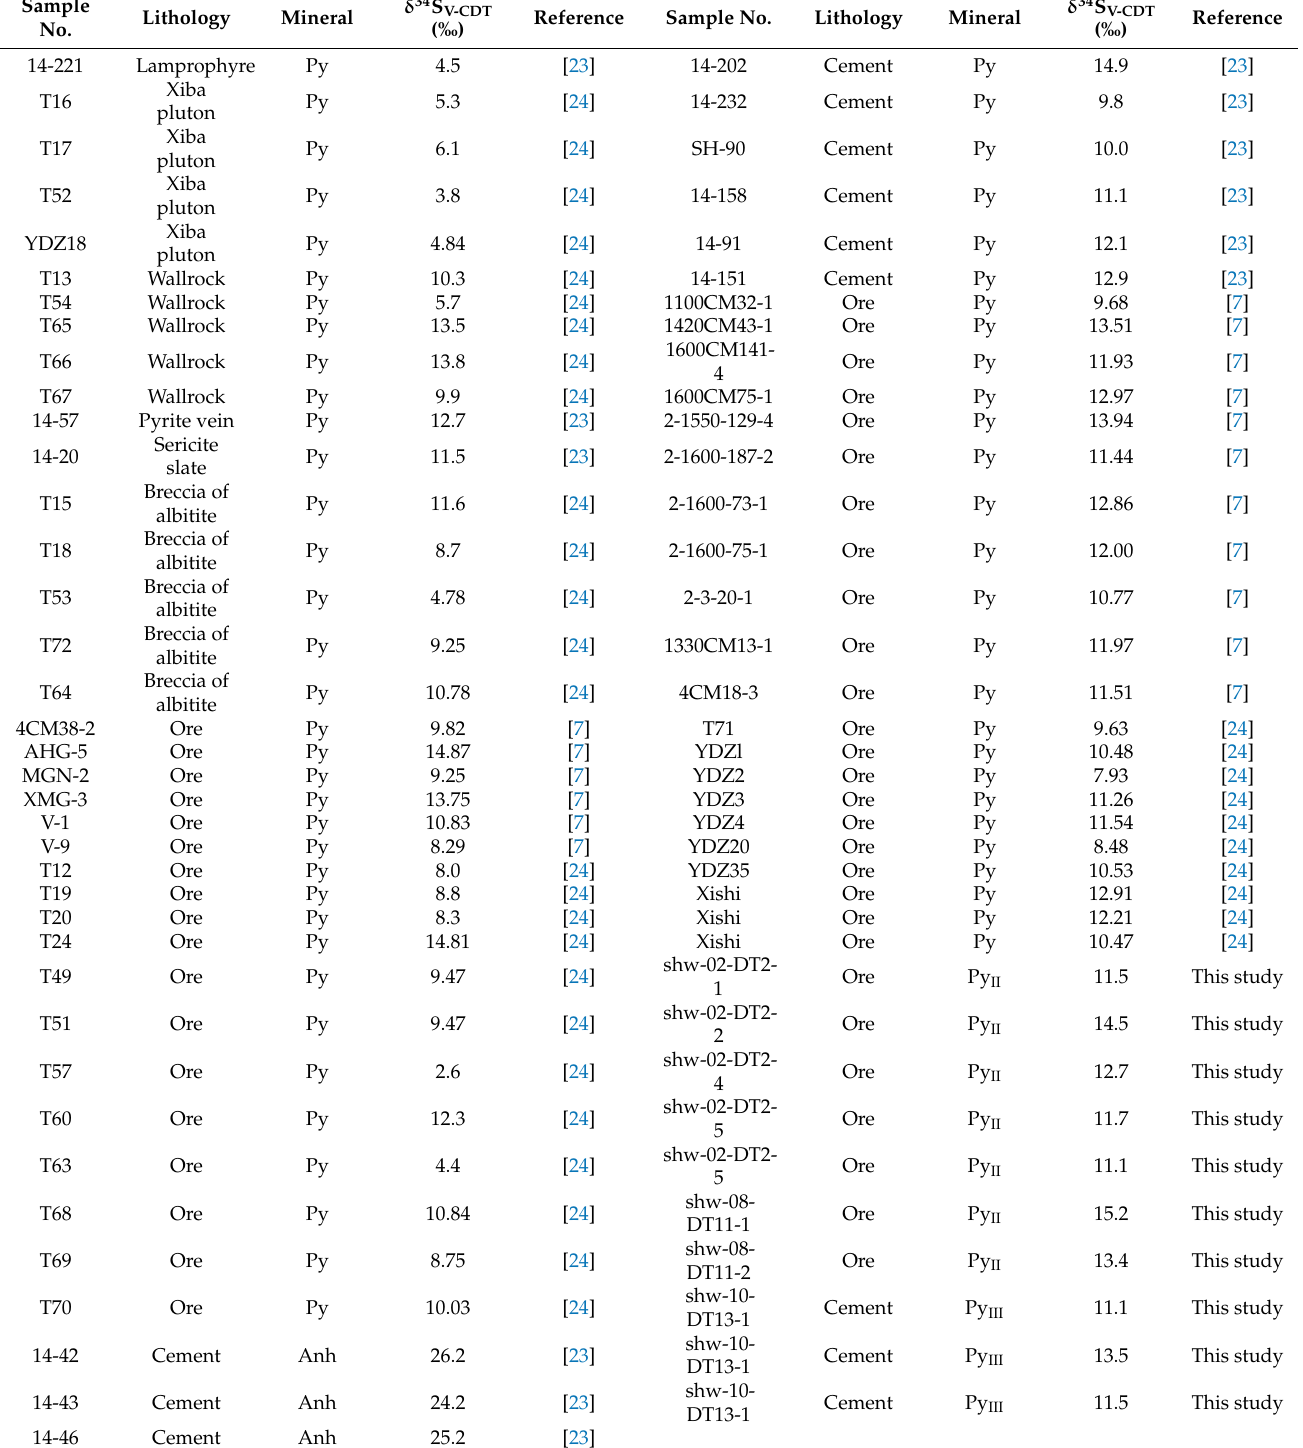
Table 2. Summary of sulfur isotope results from the Shuangwang gold